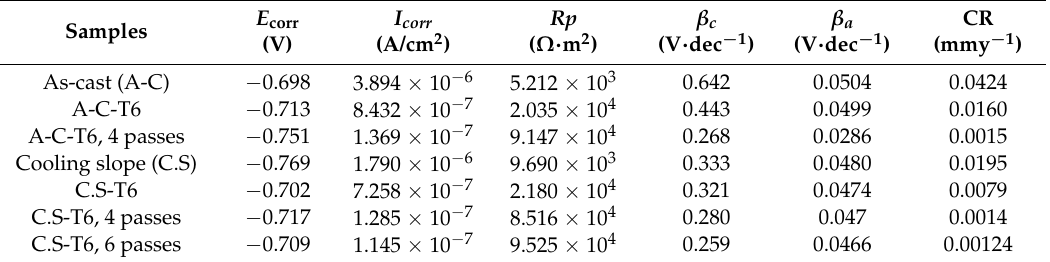
Table 2. Average of corrosion rate (CR), polarization resistance ( Rp ) and current density ( I corr ).